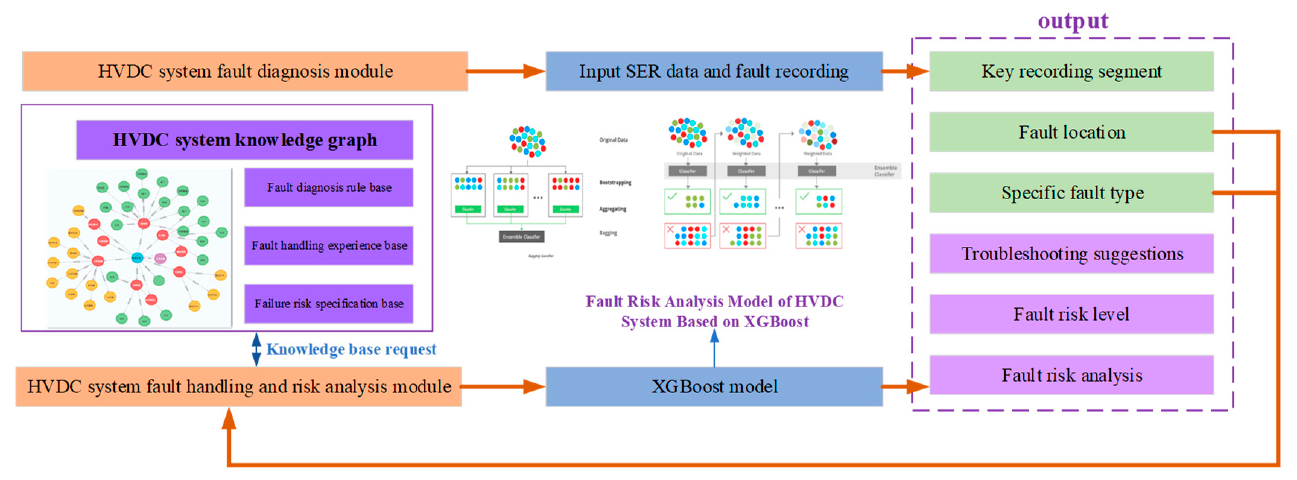
Figure 2. Flow chart of KG-based DC transmission system fault handling and risk analysis module.